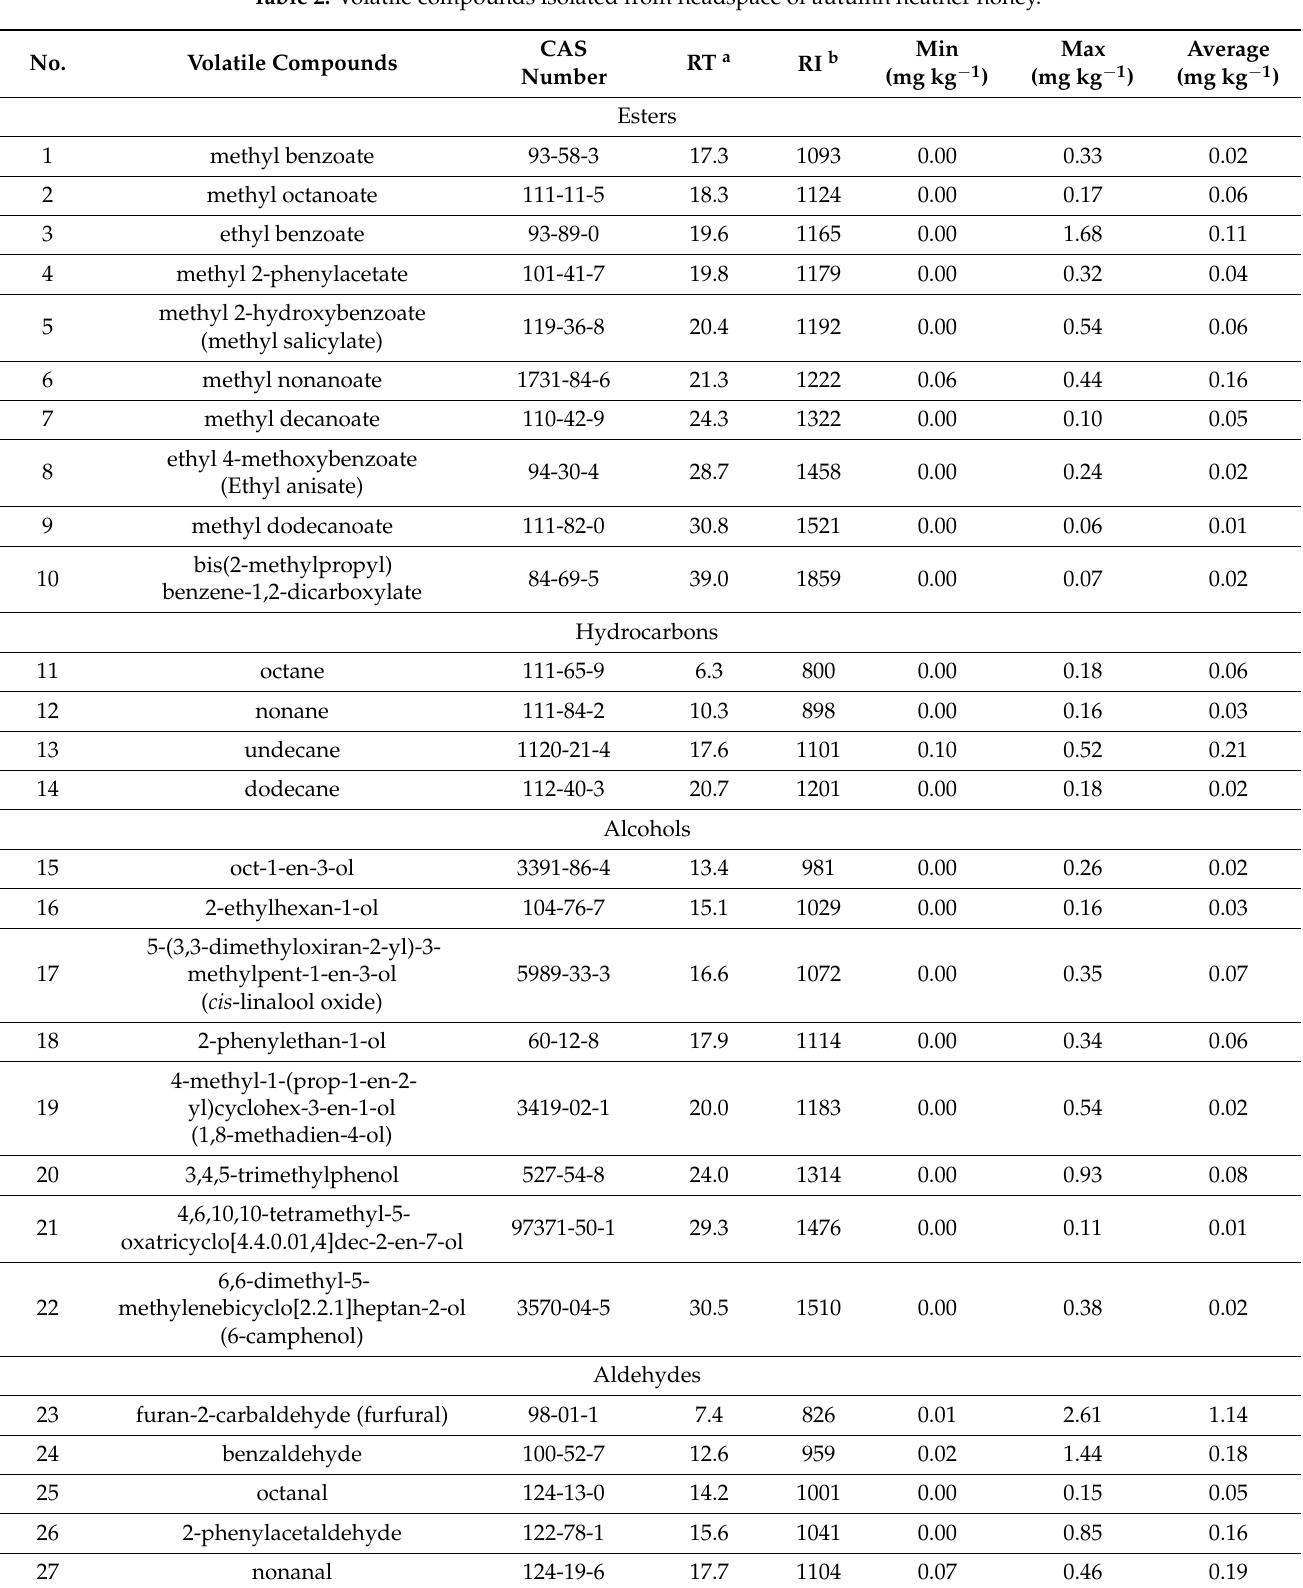
Table 2. Volatile compounds isolated from headspace of autumn heather